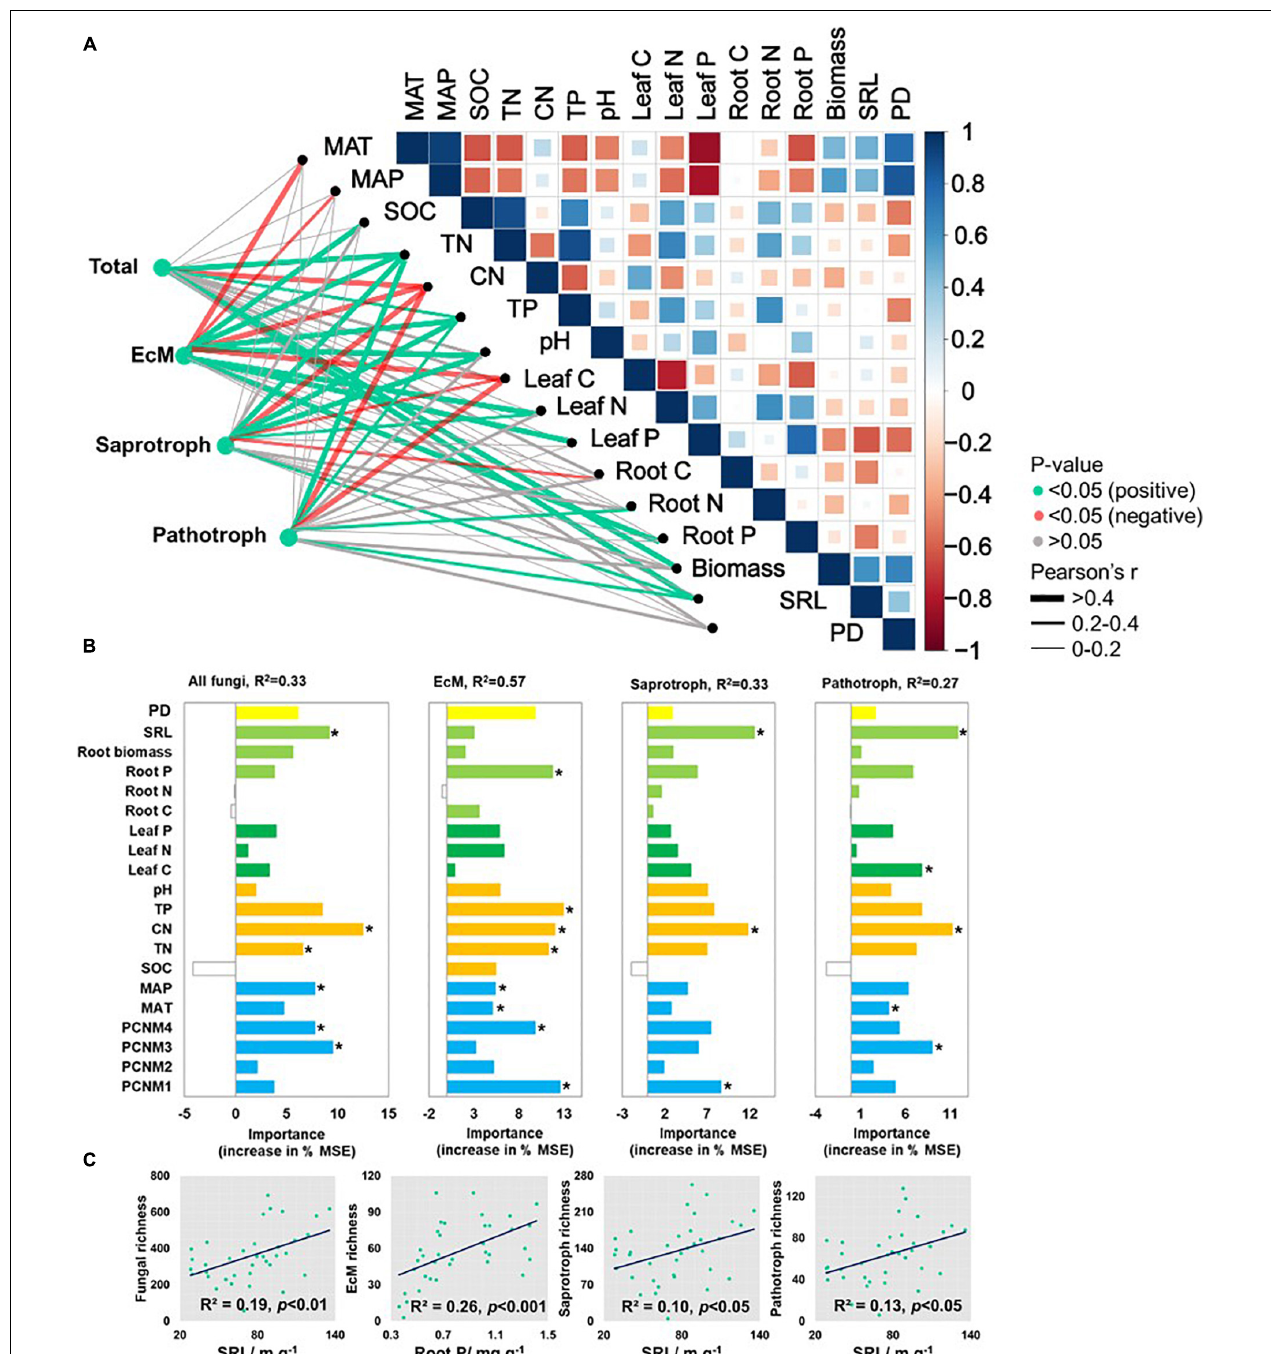
FIGURE 3 | (A) Environmental variables correlated with total and major fungal functional richness in nine forest ecosystems. Correlation and significance were determined by Pearson’ tests. (B) Random forest analysis identifying best individual predictors of fungal richness including plant traits, soil properties, and climatic and spatial factors. (C) Scatterplots showing relationships with most significant drivers. MSE: mean square error. * p < 0.05.